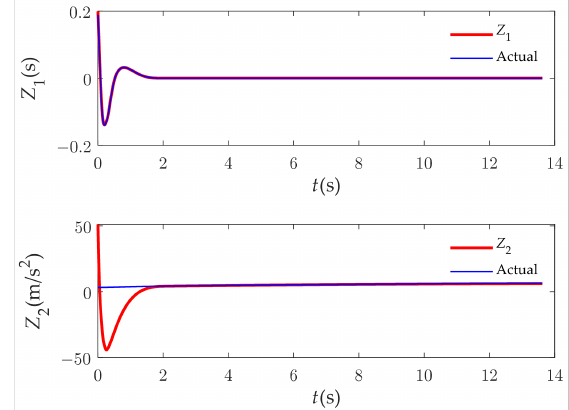
Figure 10. Actual and estimated values of